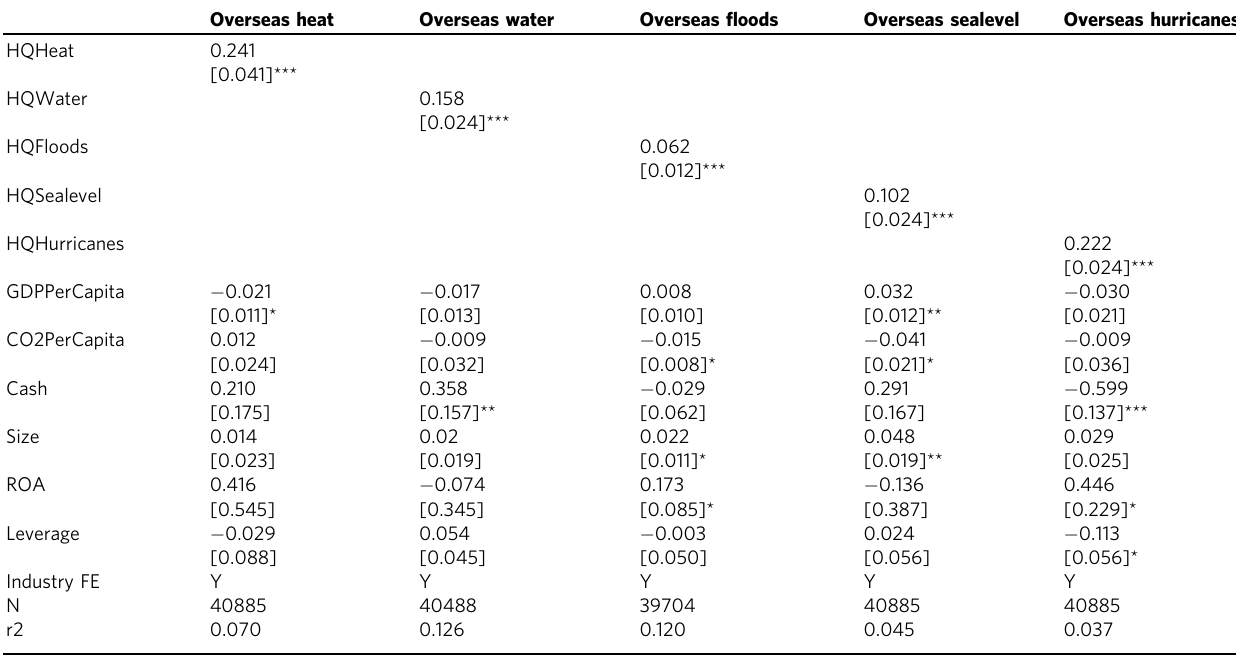
Table 3 Climate risks in fi rms ’ headquarter countries and those of fi rms ’